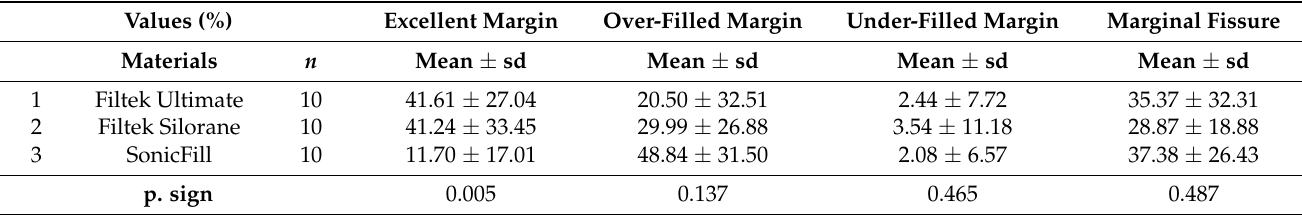
Table 2. Marginal adaptation to the gingival margin—results.